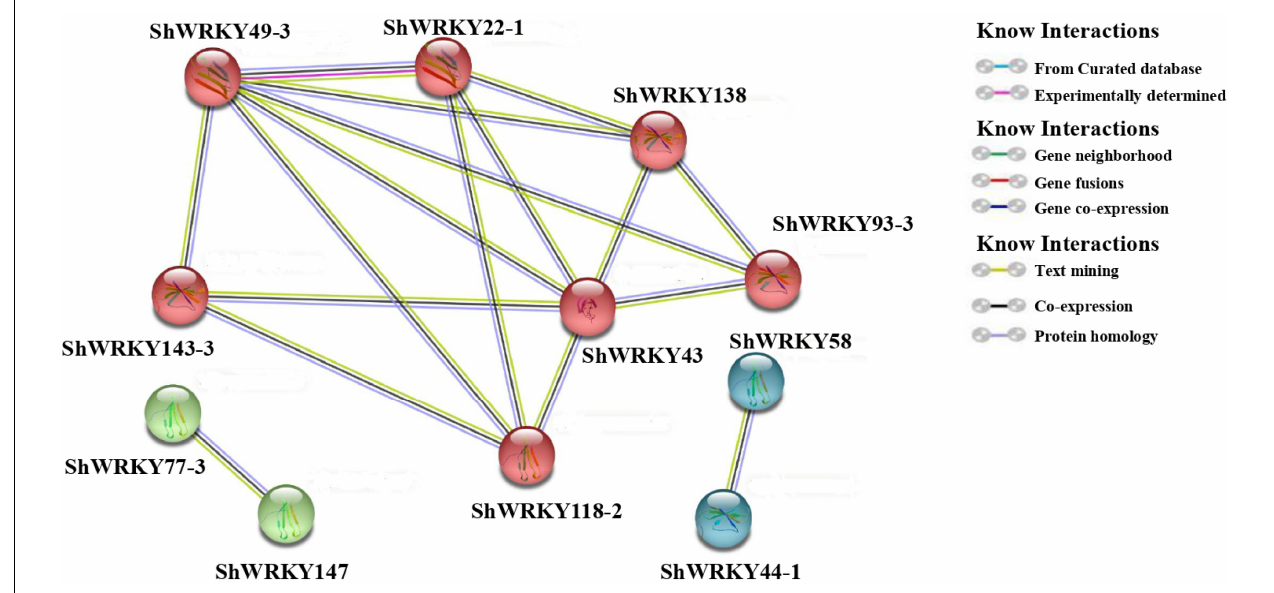
FIGURE 7 | Predicted protein-protein interactions of ShWRKYs according to their orthologs in A. thaliana . Only those pairs with > 30% sequence identity between ShWRKYs and AtWRKYs and an interaction score > 0.8 are shown in the network. Line and node colors indicate different kinds and degrees of interactions, respectively. Ribbon diagrams are shown in each